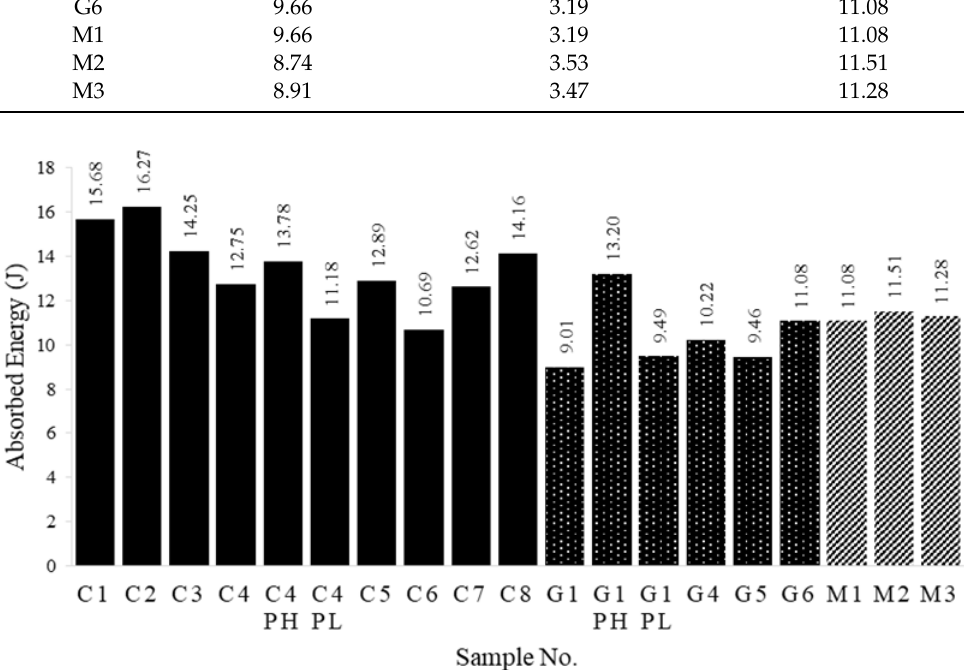
Figure 4. Summary of the measured absorbed energy for all composite plates.